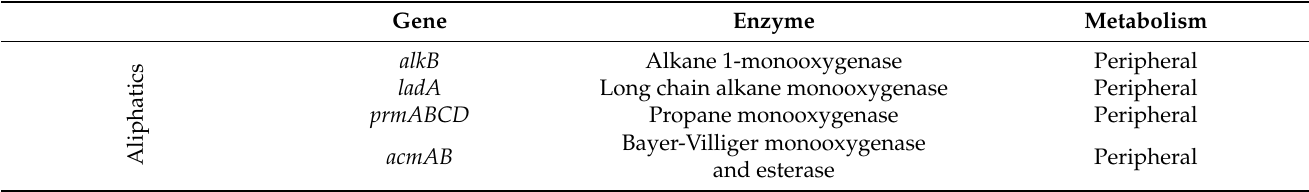
Table 3. List of the genes coding for the main enzymes involved in the peripheral and central metabolic pathways for the degradation of aliphatic and aromatic